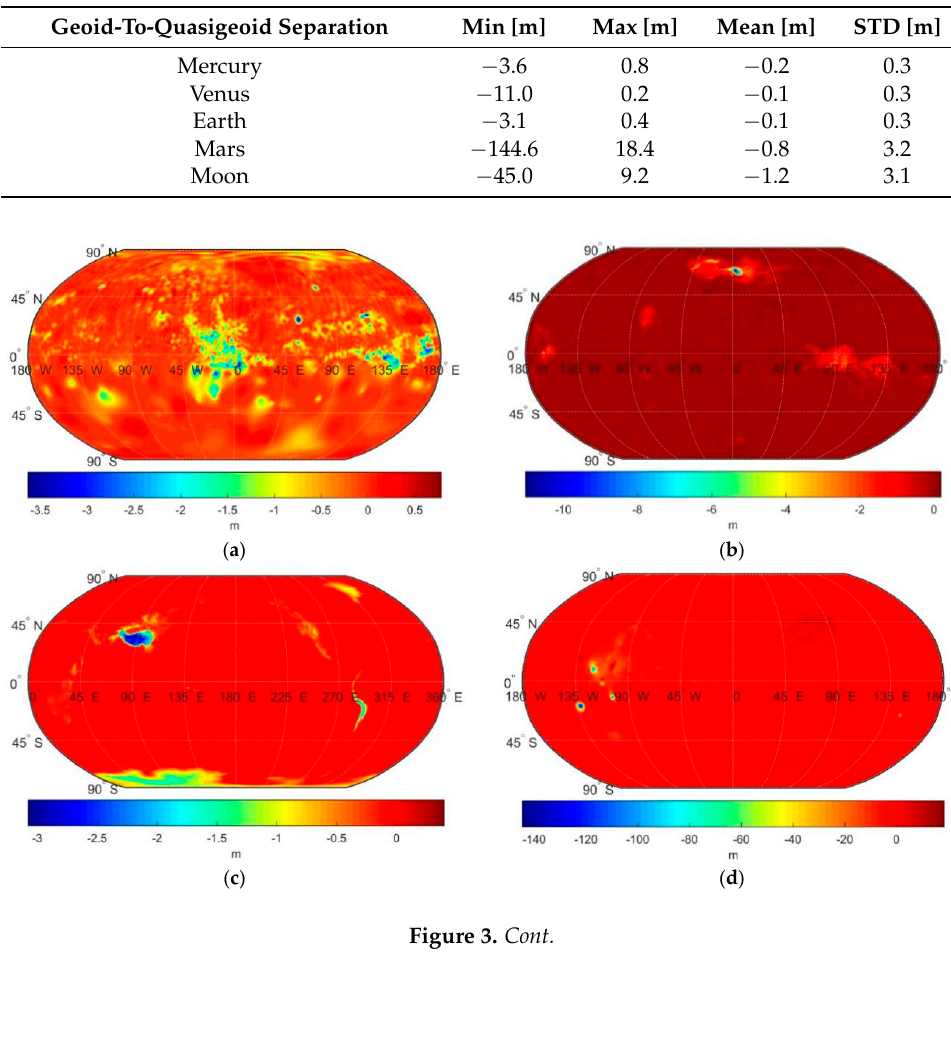
Table 3. Statistics of the geoid-to-quasigeoid separation on Mercury, Venus, Earth, Mars and the Moon.